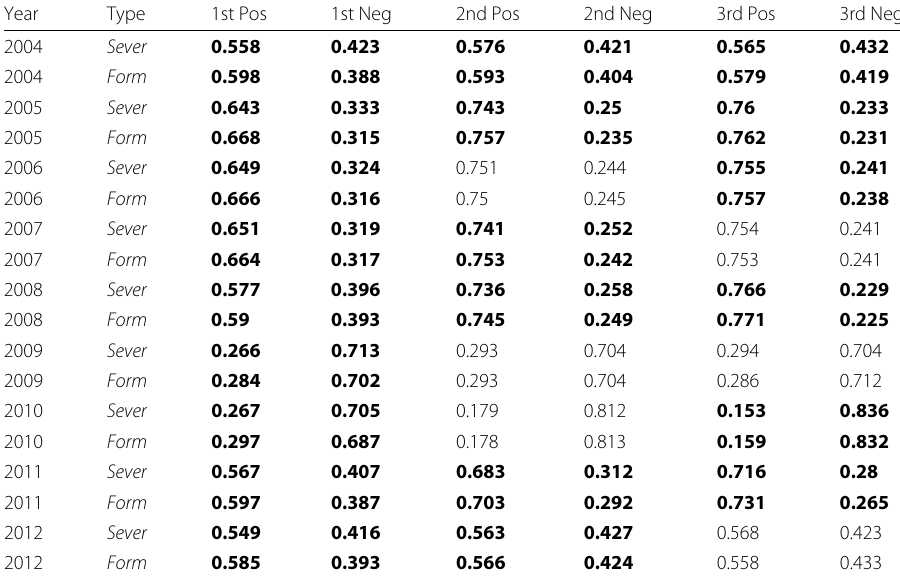
Table 3 Proportions of positive and negative log growth rates of firms around a newly formed or severed link